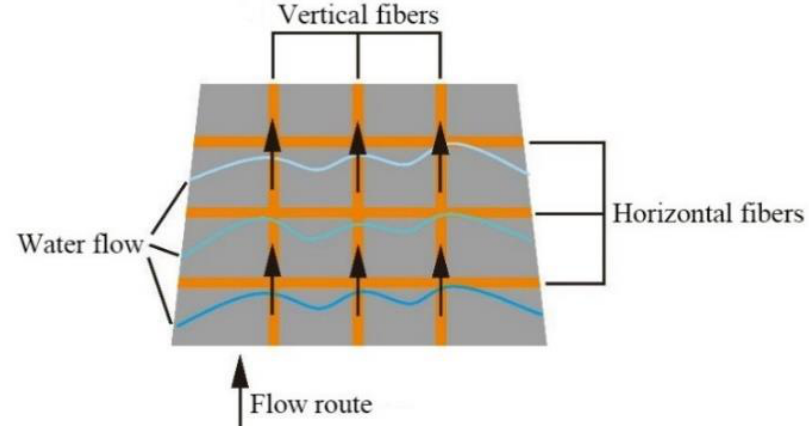
Figure 15. Bidirectional joint cracks.